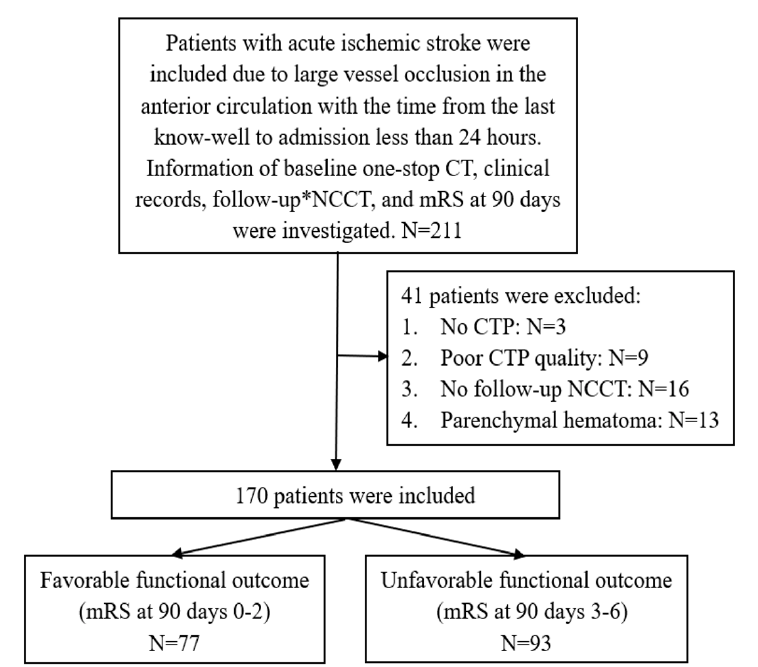
Figure 1. Flowchart describing the inclusion and exclusion criteria of this study; one‑stop CT (in‑ cluding NCCT, CTP, and CTA); * 3–7 days after endovascular treatment or admission. Among the 170 patients included, the median (IQR) age was 68 (57–76) years, 60 pa‑ tients (35.3%) were women, the median (IQR) baseline NIHSS was 11 (6–18), and the me‑ dian (IQR) time from the last known‑well to the hospital was 5 (2–9.3) hours. Thrombec‑ tomy and thrombolysis were performed in 114 (67.1%) and 23 (13.5%) patients, respec‑